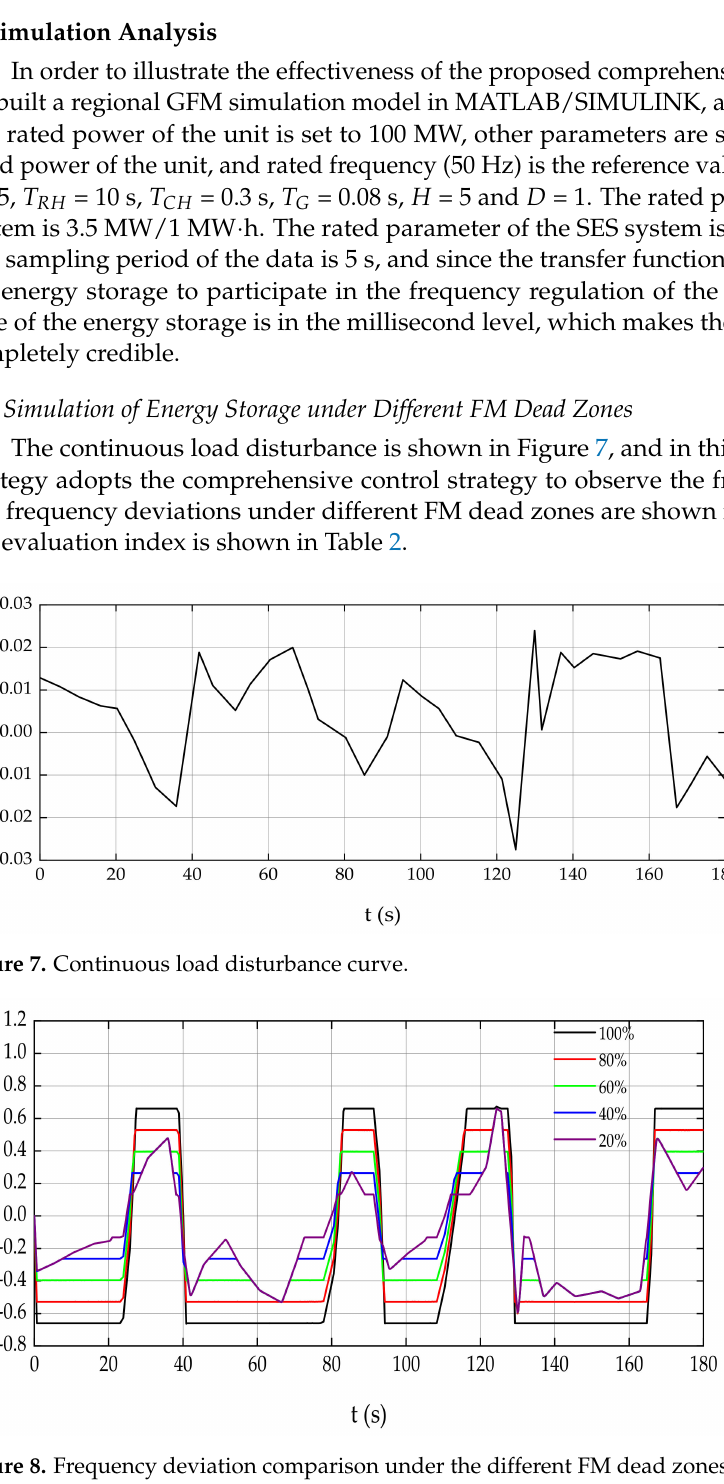
Figure 8. Frequency deviation comparison under the different FM dead zones of energy